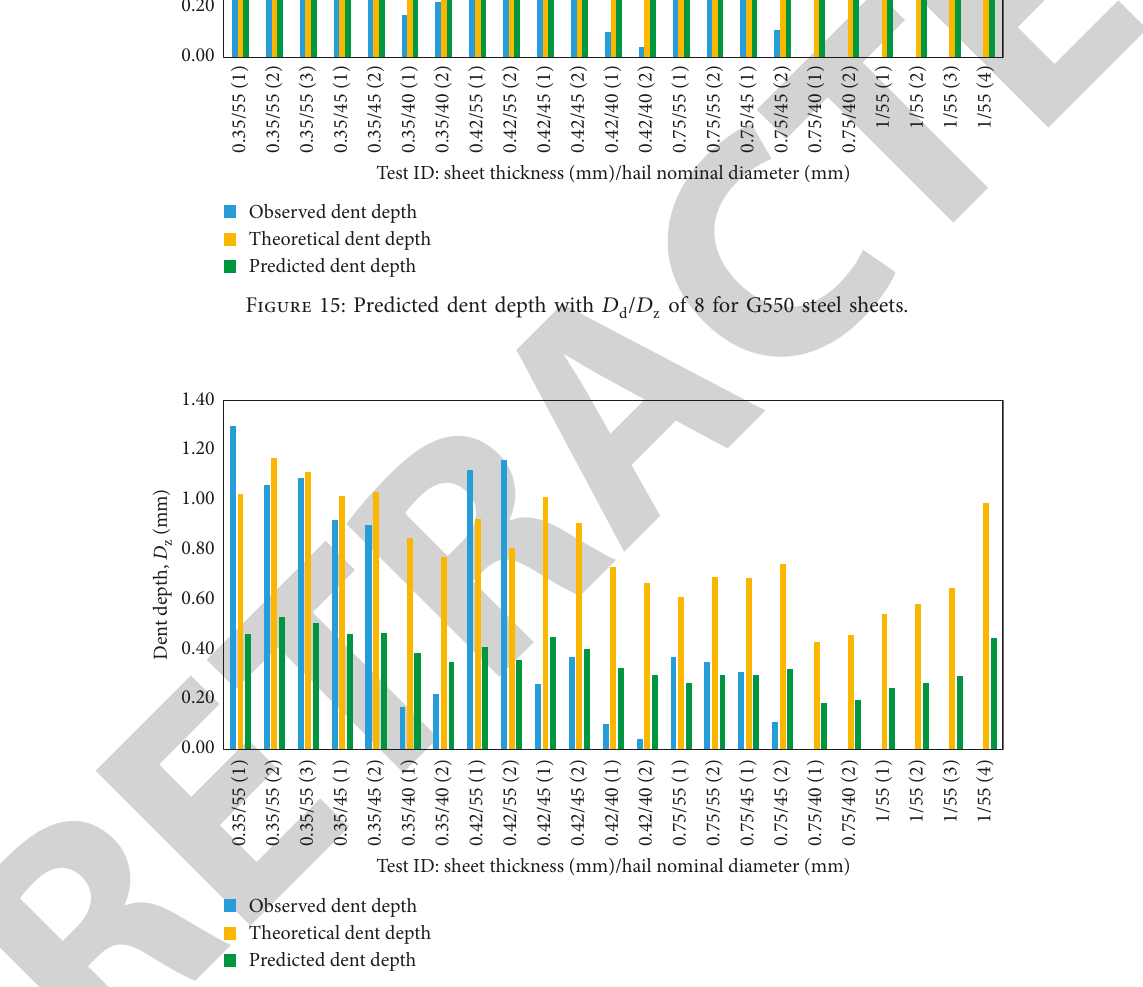
Figure 16: Predicted dent depth with D